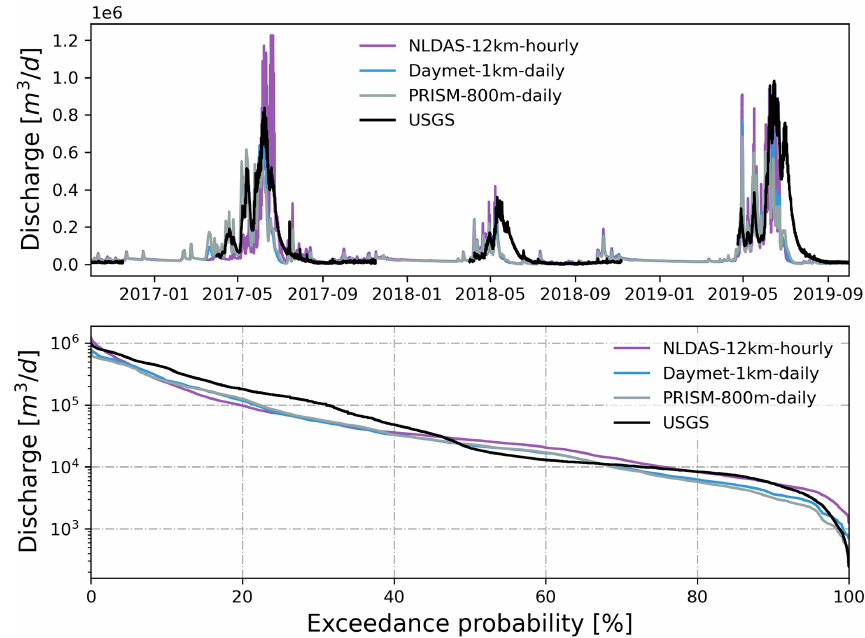
Figure 6. Simulated hourly discharge at the watershed outlet compared to USGS hourly streamflow forced by different temperatures from each GMF. Also shown is the flow duration curve